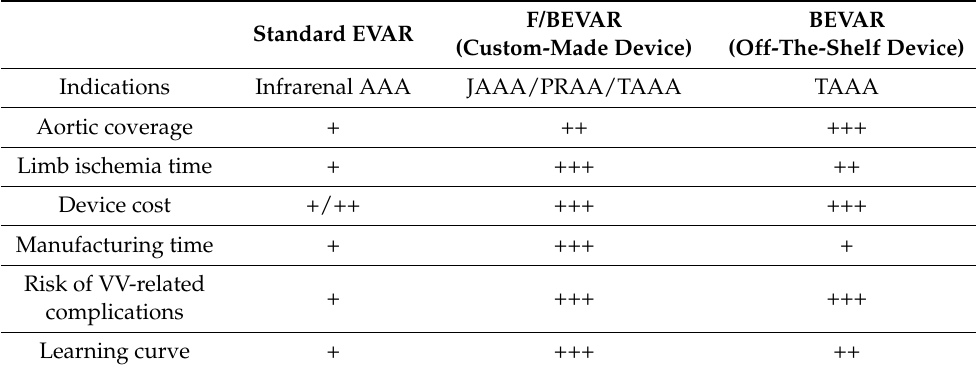
Table 1. Summary of EVAR and F/BEVAR indications, pros and